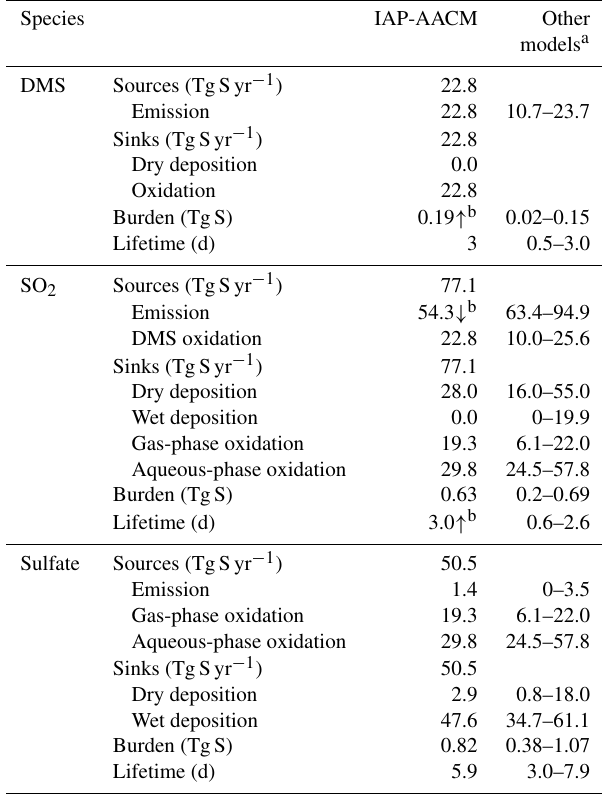
Table 4. Global budgets for DMS, SO 2 , and sulfate.